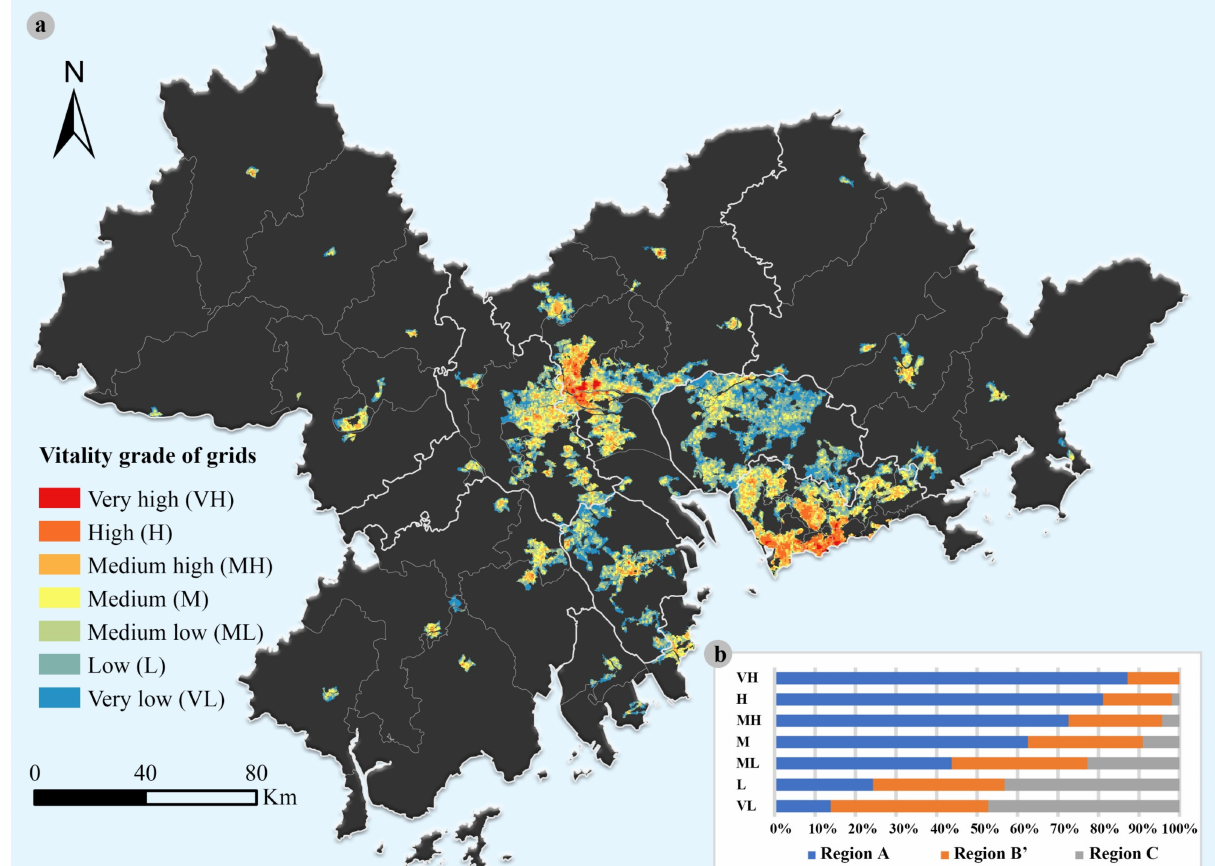
Figure 8. Result of urban vitality evaluation with a 500 m grid, classified in seven grades by natural breaks. ( a ) The spatial distribution; ( b ) The proportion of grids in built-up